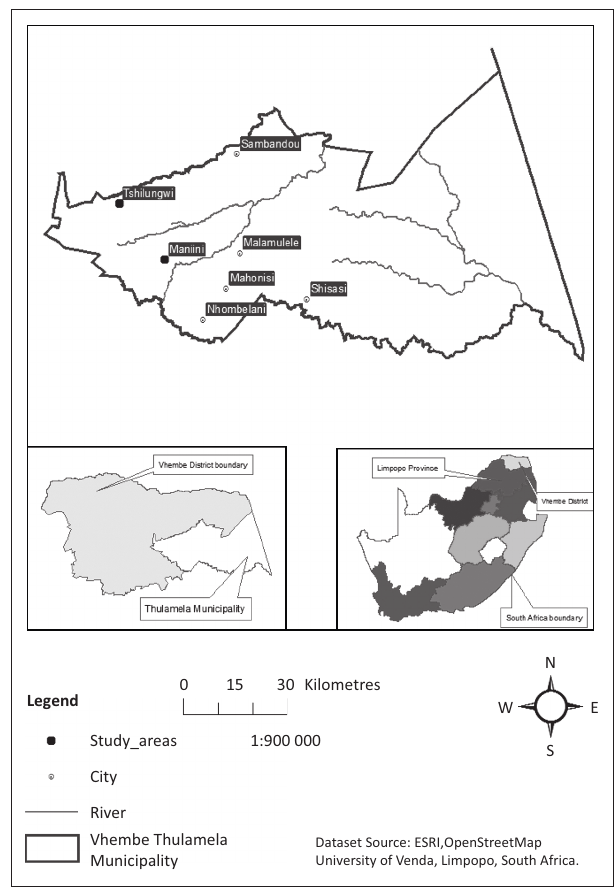
FIGURE 2: Map of study